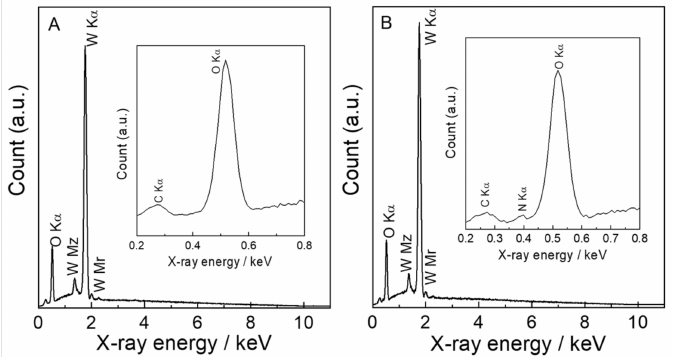
Figure 2. The EDS data of ( A ) WO 3 − 0 and ( B ) WO 3 − 2.5 in the range of 0–11 keV. (Insert) The magnified EDS data of WO 3 − 0 and WO 3 − 2.5 in the range of 0.2–0.8 keV,